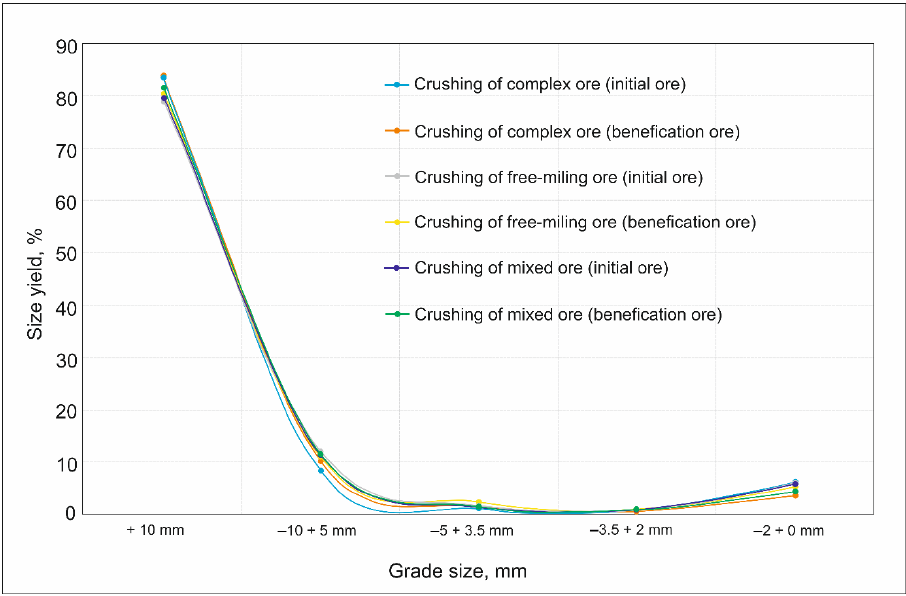
Figure 4. Distribution of size classes in the product of the first crushing stage.